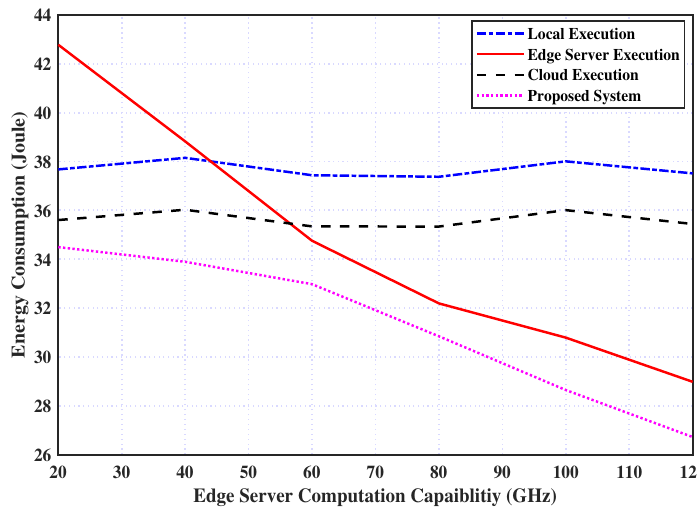
Figure 4. Energy consumption comparison under different values of edge server capability.